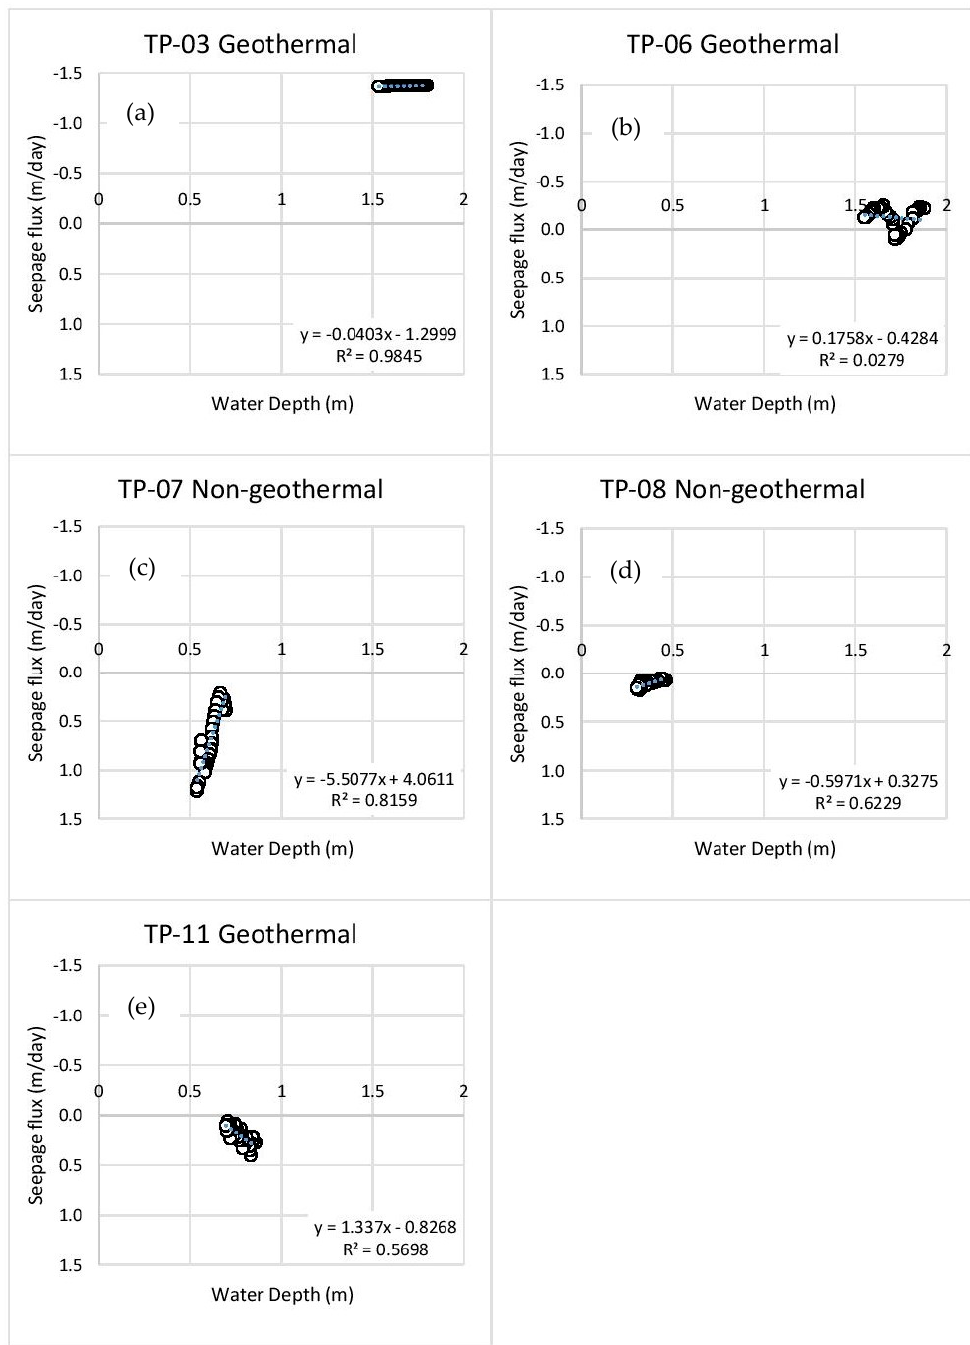
Figure 11. Seepage flux vs. depth of water above VTSA from 20 July to 22 July (three days after a rain event). Negative slopes indicate increased seepage flux with river stage. Figures ( a – e ) correspond to TP-03, TP-06, TP-07, TP-08, TP-11 VTSA locations as marked in Figure 5.